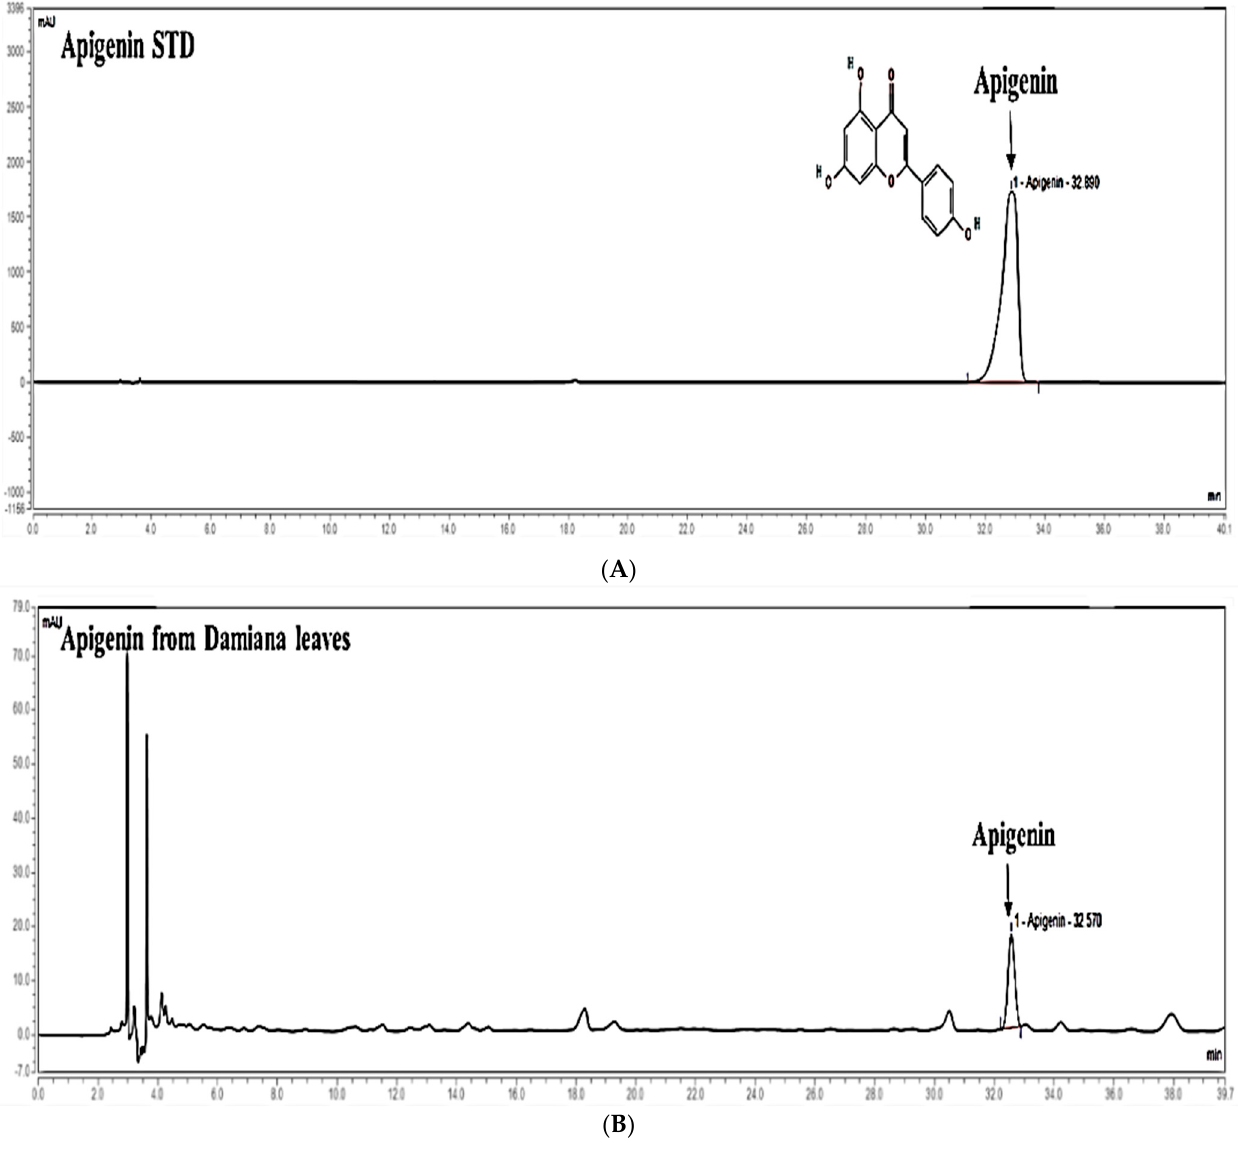
Figure 1. HPLC analysis of standard apigenin ( A ) and Damiana leaves extract ( B ) at 330